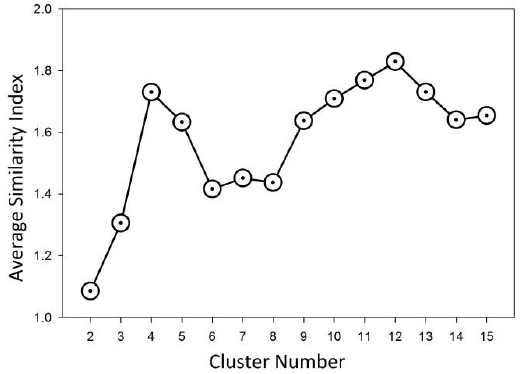
Figure 4. Average similarity index with various numbers of clusters using FCM.